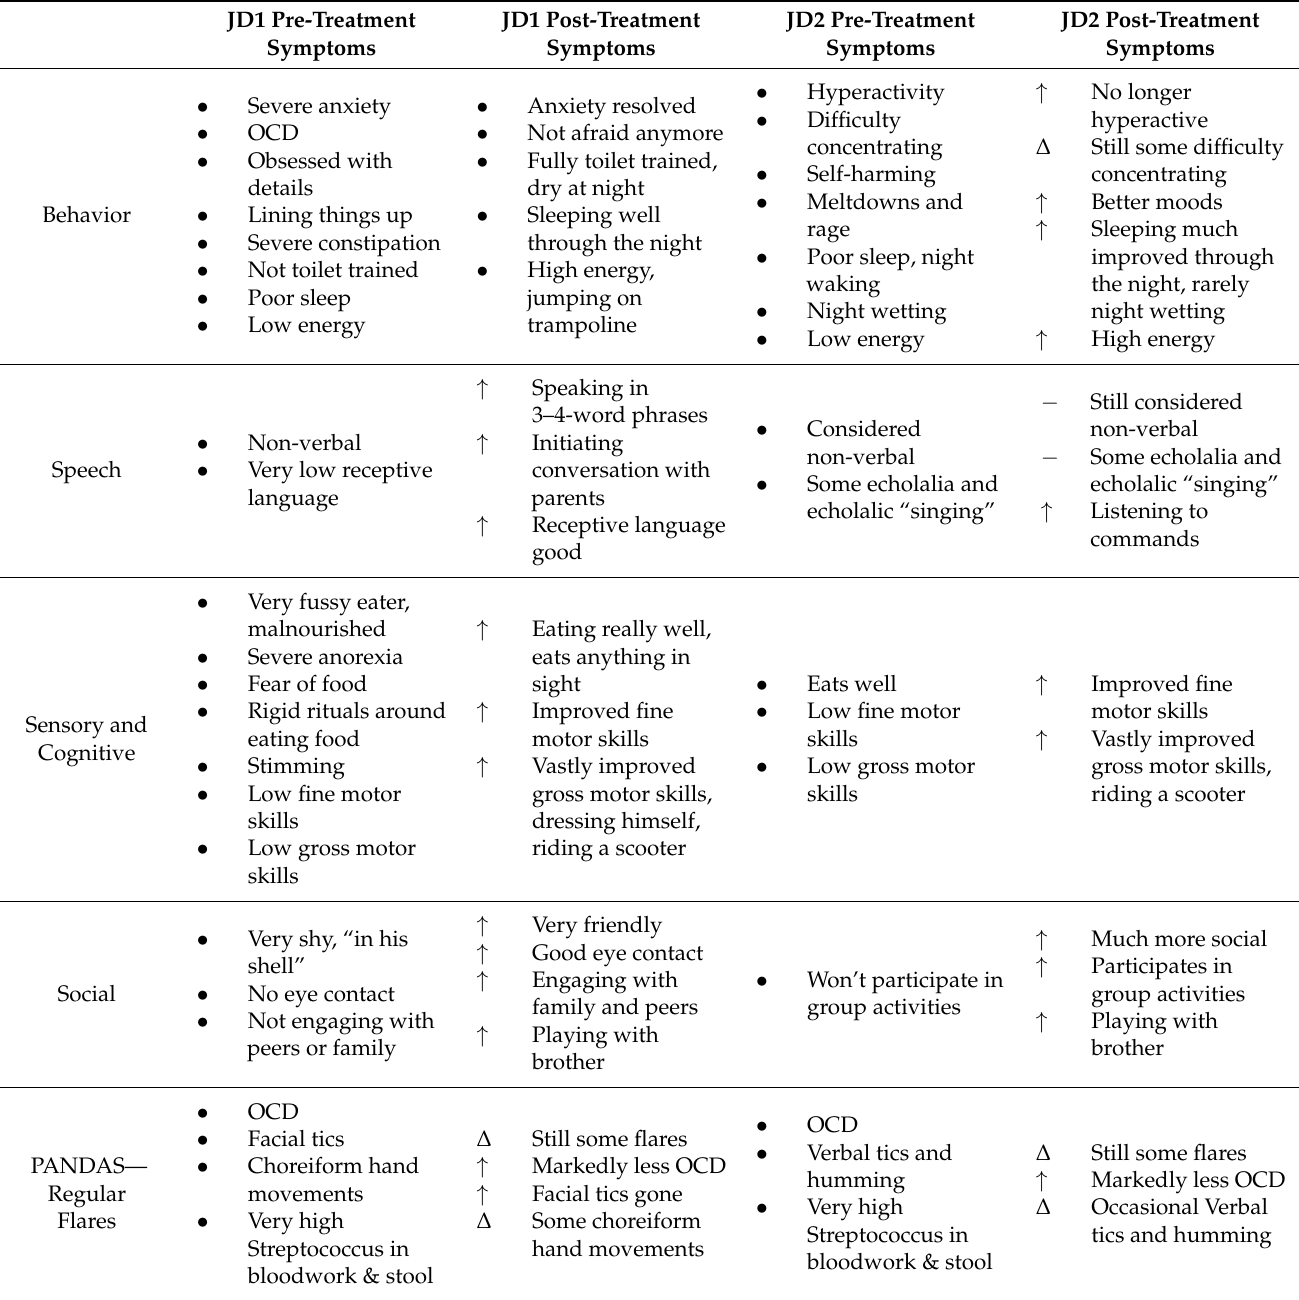
Table 1. JD1 and JD2 symptoms before and after personalized